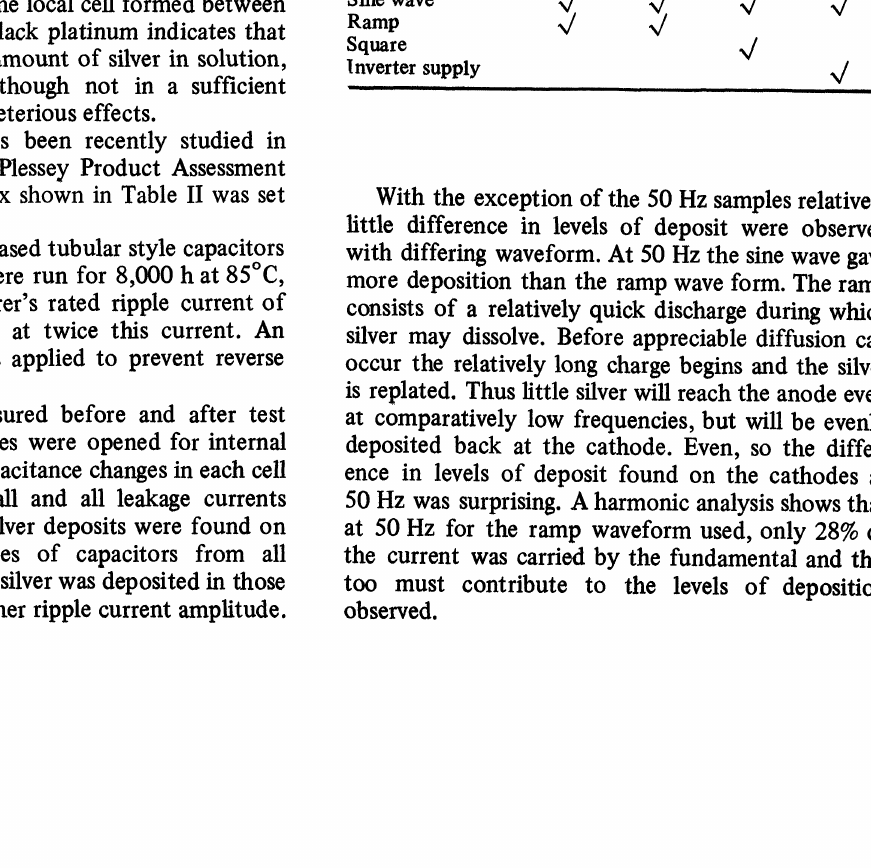
TABLE II Matrix showing ripple testing criteria applied to silver-cased tantalum